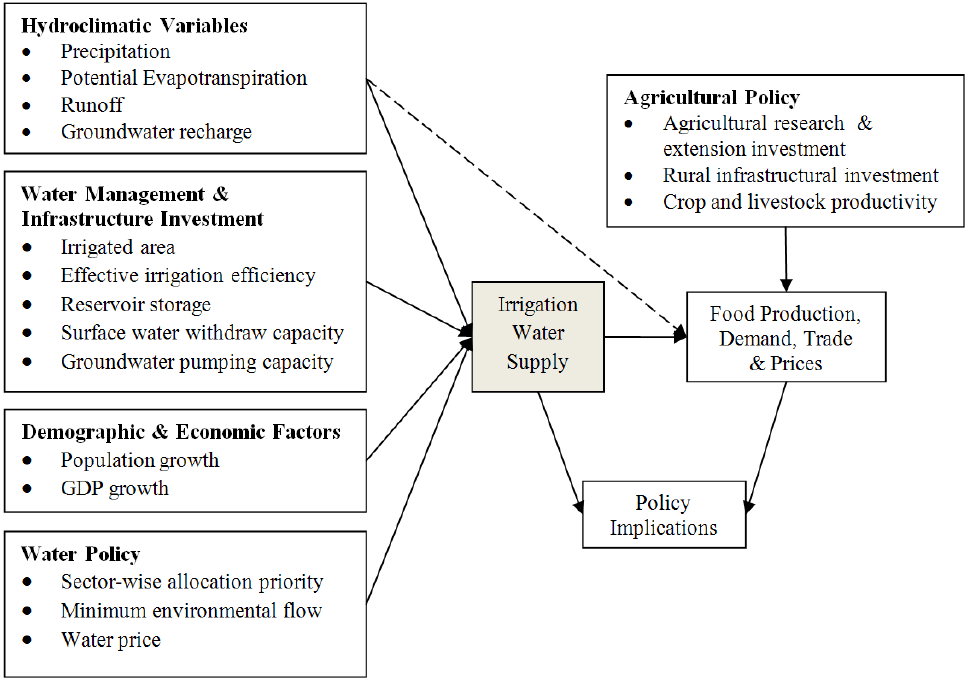
Figure 5. Driving forces in the Water Simulation Module and its linkages with the Food Module in